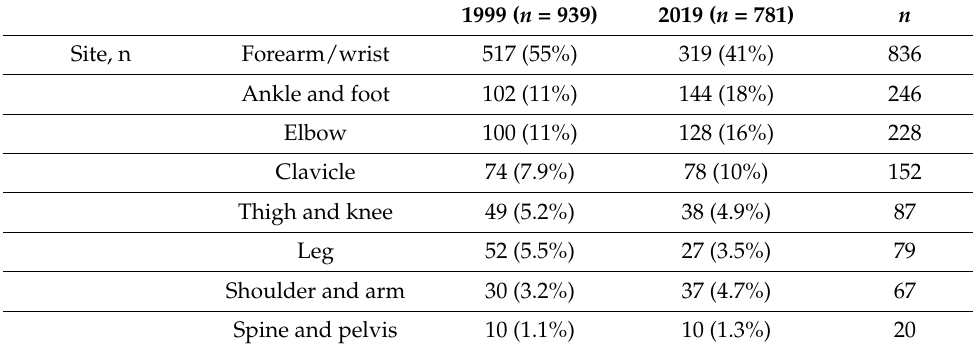
Table 4. Distribution of fractures according to site of